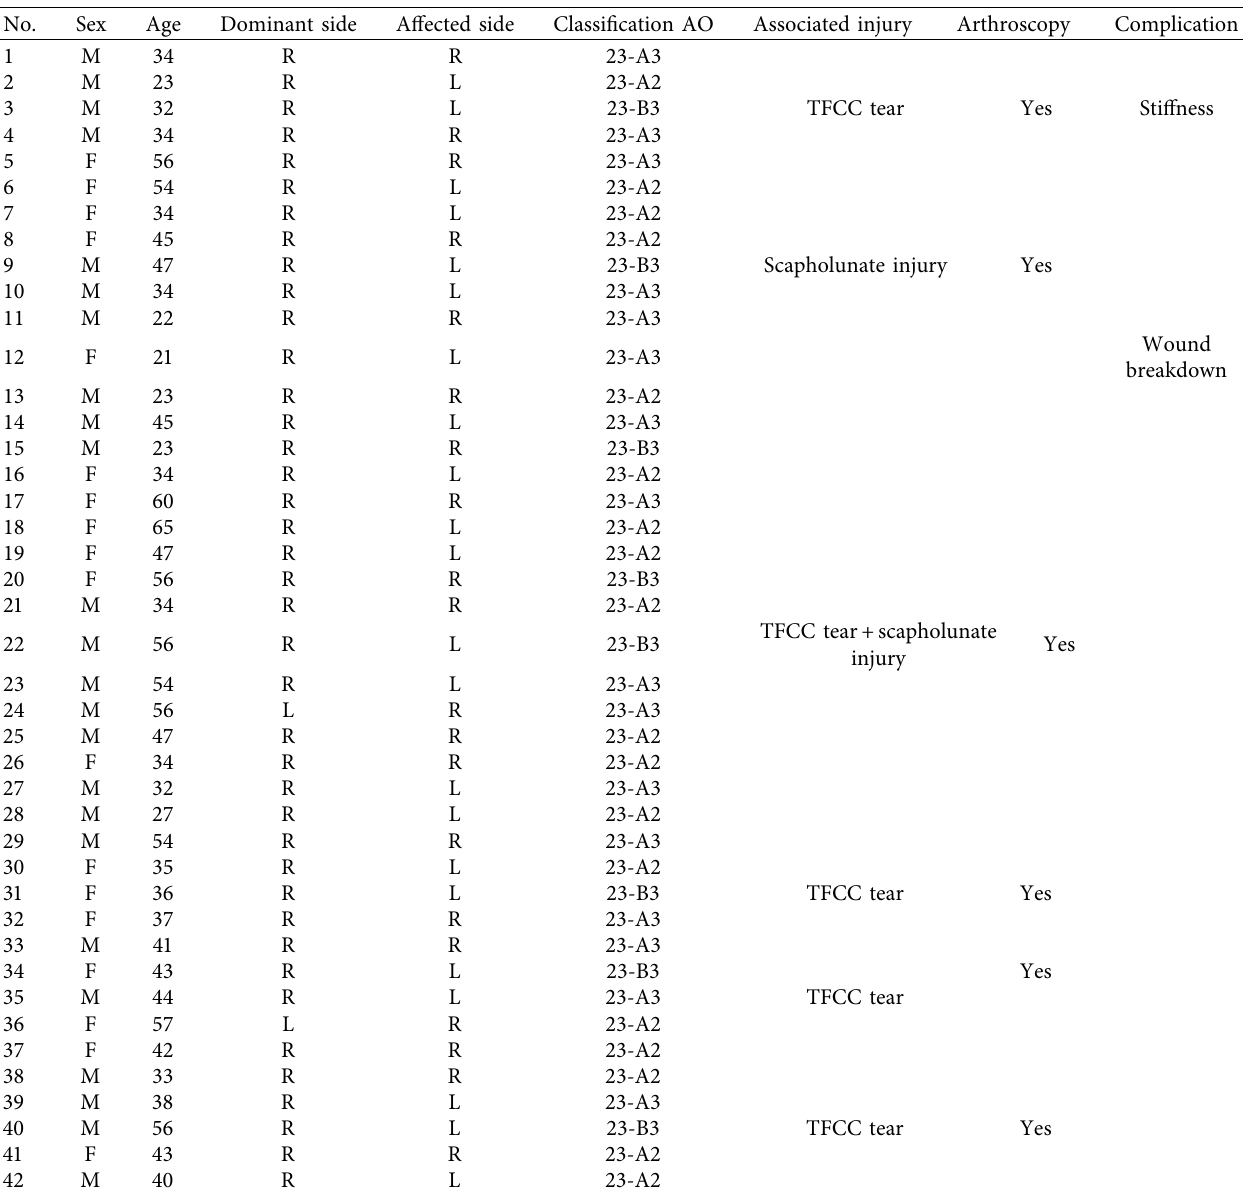
Table 2: Subjects’ fracture